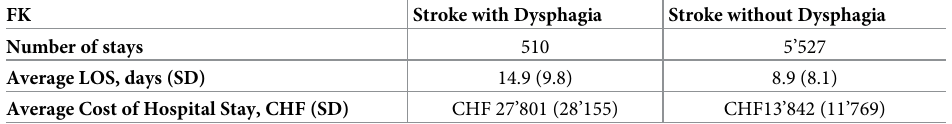
Table 4. Hospital LOS and Costs of Hospital stays for stroke with dysphagia vs. without dysphagia in Switzerland.